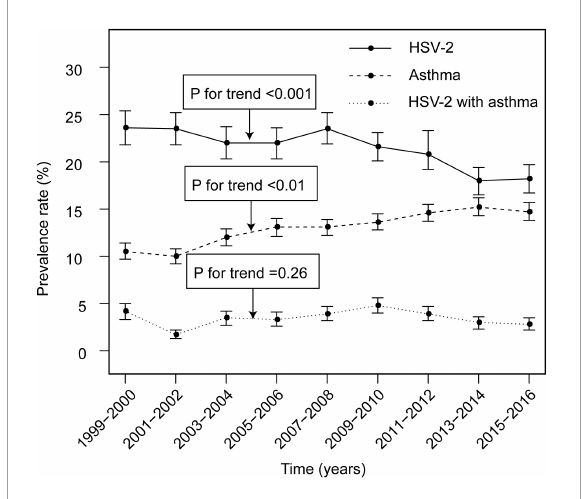
FIGURE2 Prevalence and trends of HSV-2 infection and asthma. HSV-2, Herpes simplex virus type 2.